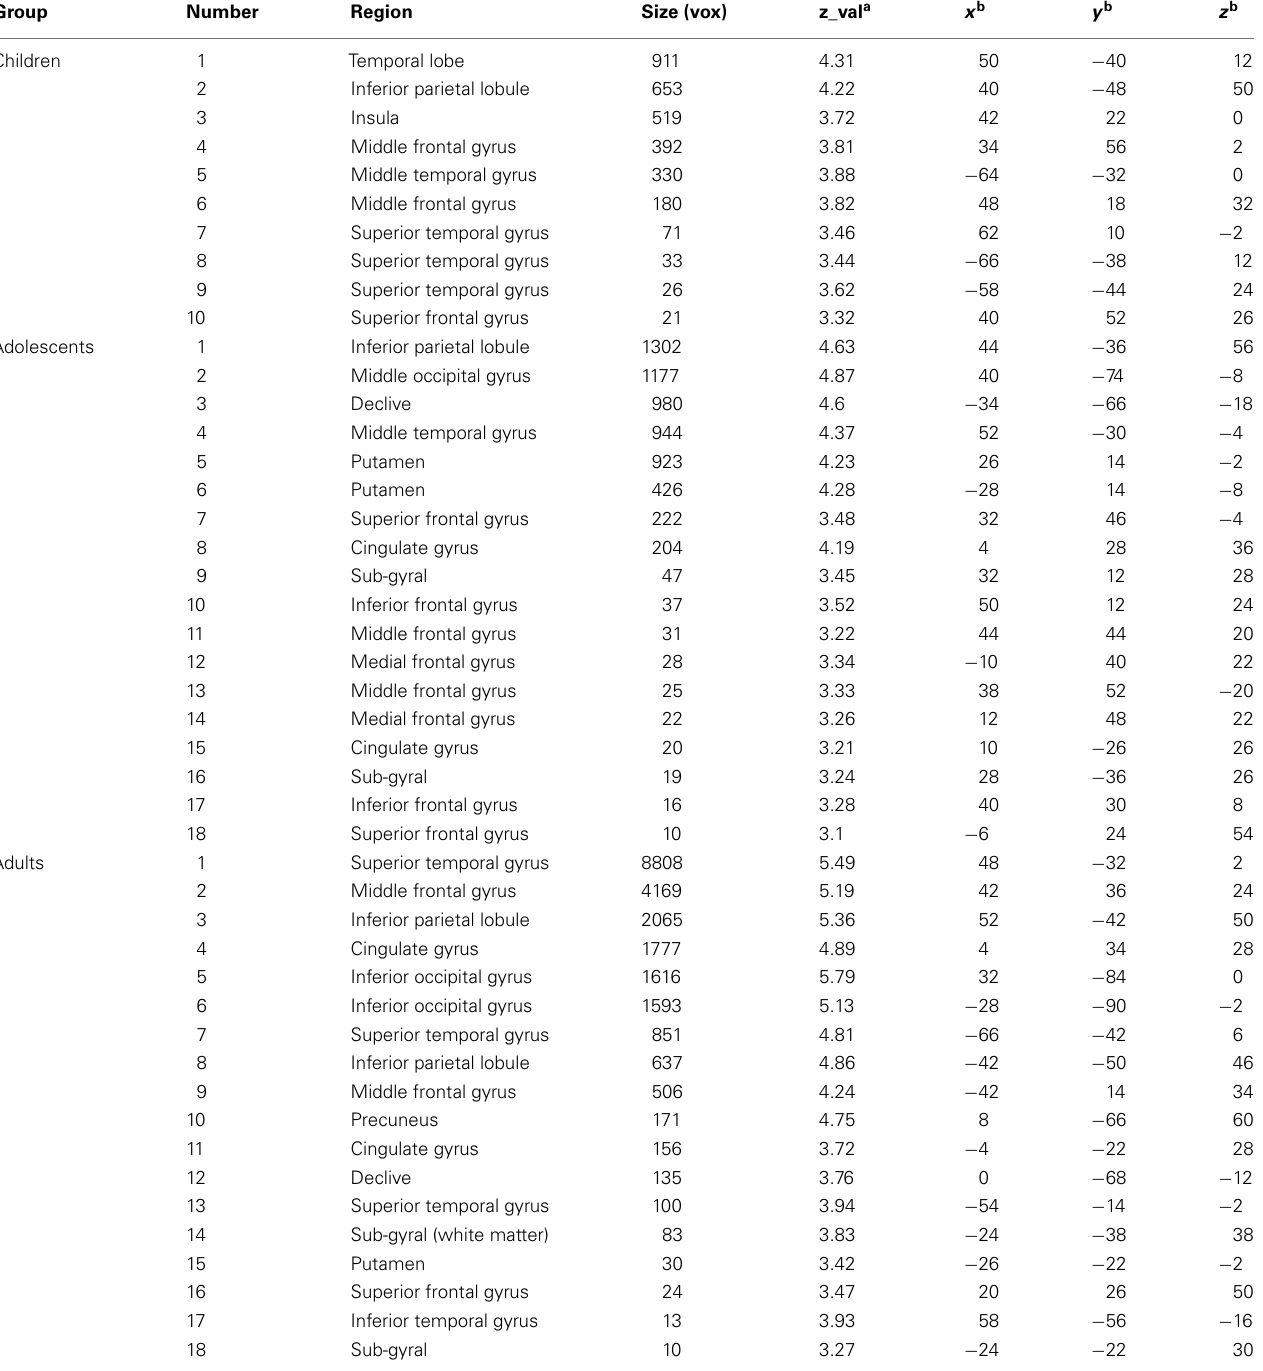
TableA2 |Activation to winning outcomes by age group.